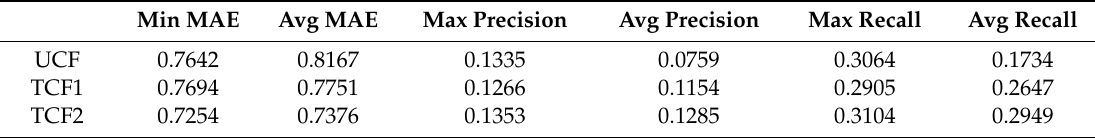
Table 6. Statistical results on performance of di ff erent methods.